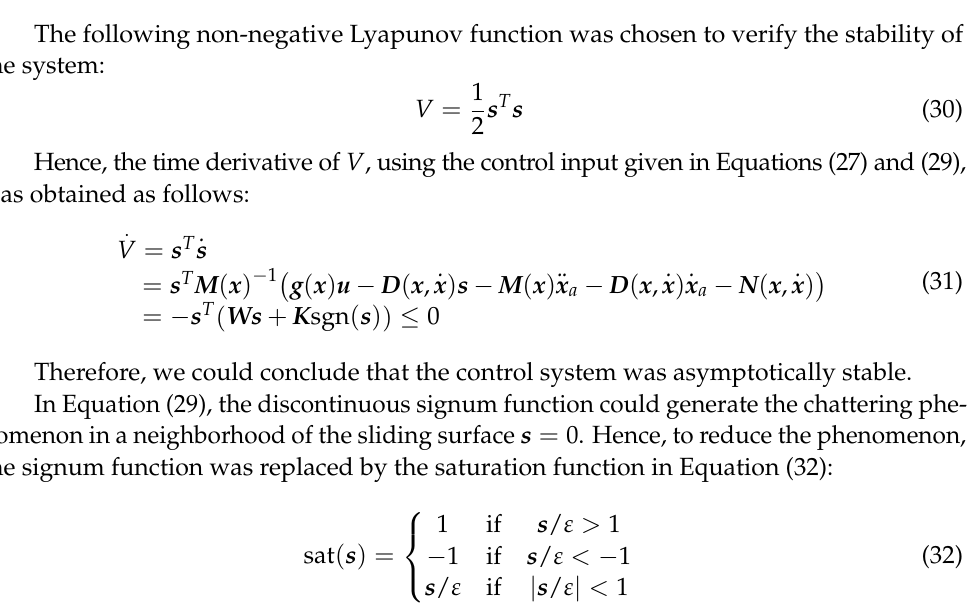
Figure 3. A schematic drawing of a standard